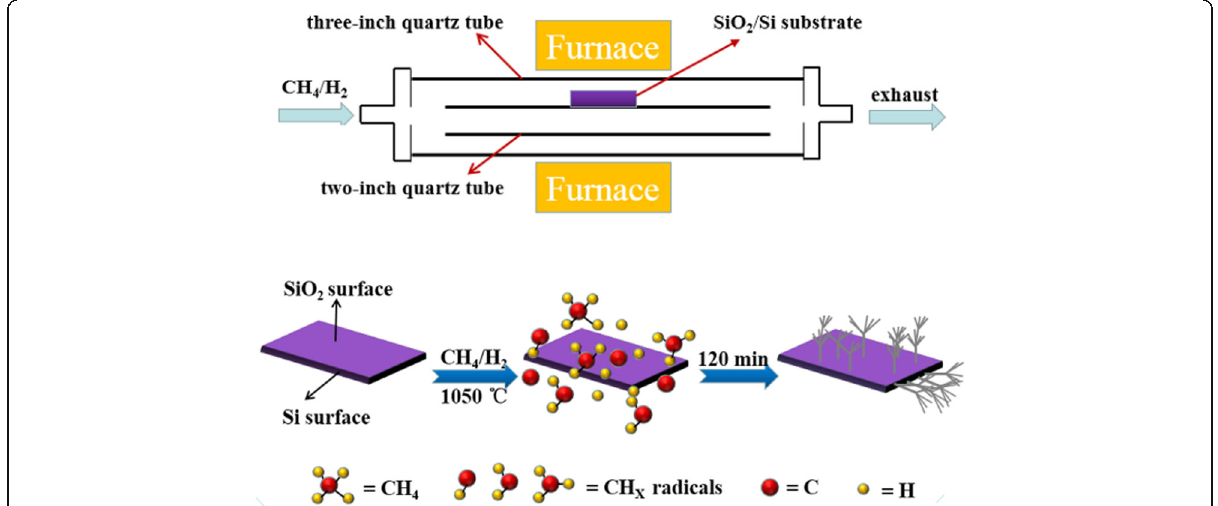
Fig. 1 Schematic illustration of CVD process for growing graphene